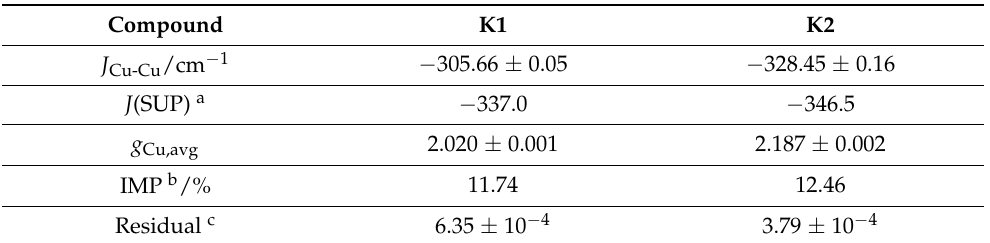
Table 3. Fitted values of J Cu-Cu , g Cu,avg , and IMP contribution. The J (SUP) a was extracted from the broken symmetry and spin-flip DFT results (for details, see SI